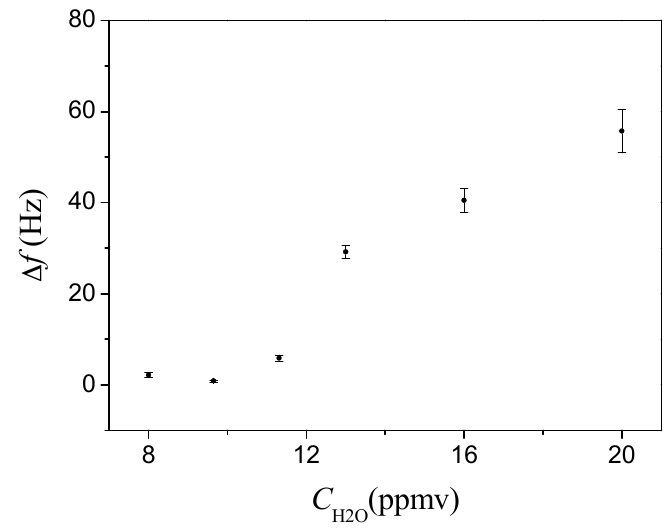
Figure 4. The effect of humidity on the [bmim][BF 4 ]-modified QCM sensor.